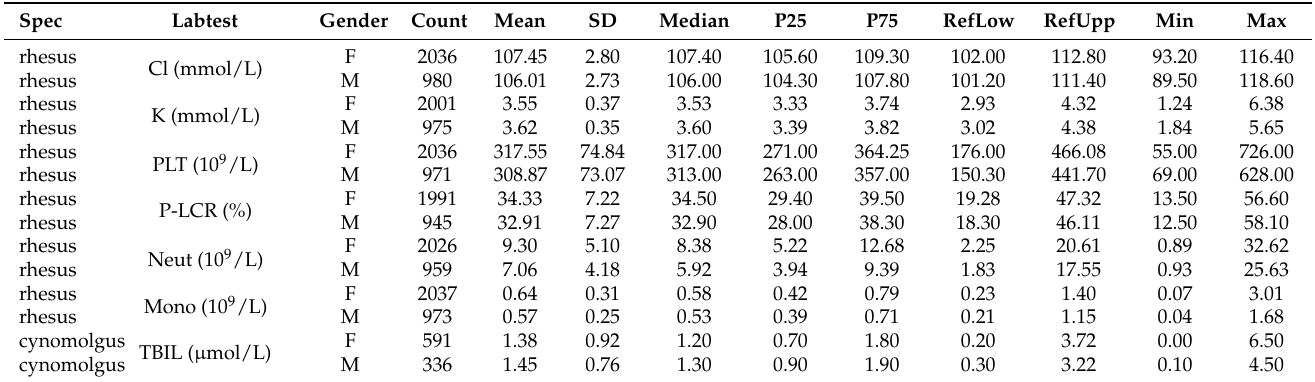
Table 10. Combined reference intervals for age, partitioned per